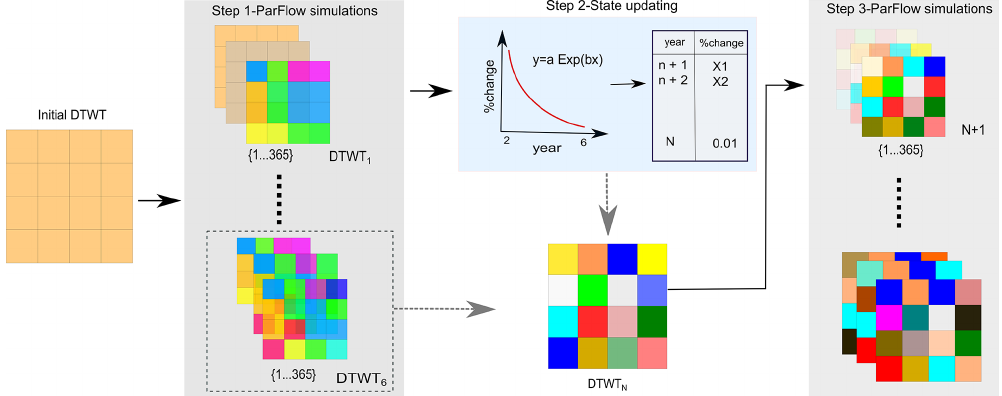
Figure 1. The hybrid spin-up approach consists of three main steps: (1) initial ParFlow.CLM spin-up simulations based on an arbitrary DTWT distribution, (2) a state-updating step by developing a DTWT function based on percentage changes in mean annual DTWT in initial spin-up simulations, and (3) stage 2 of ParFlow.CLM spin-up simulations until the desired equilibration level is